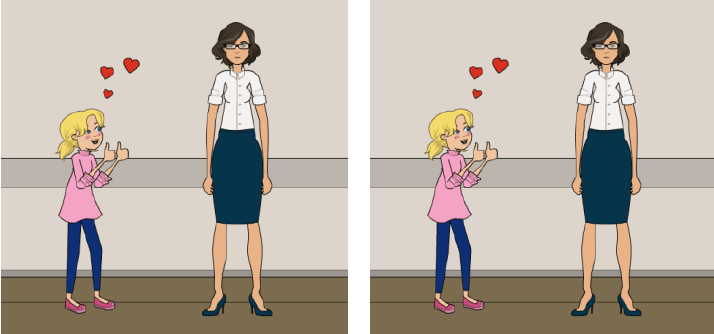
Source: Image created by author using Pixton